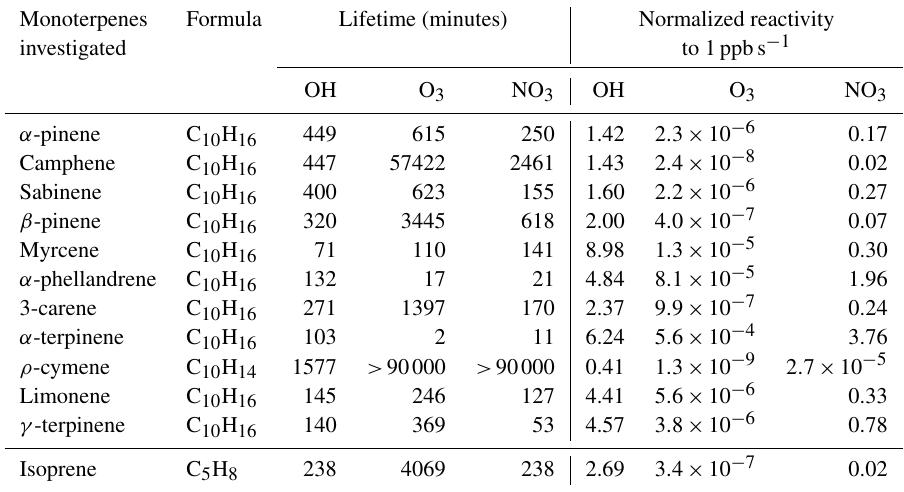
Table 2. Lifetime of the different monoterpene species related to OH, O 3 and NO 3 for the OH daytime conditions at 24 and 12m. In addition, the normalized reactivity to 1ppb of the different monoterpene species is calculated. Monoterpenes Formula Lifetime (minutes) Normalized reactivity